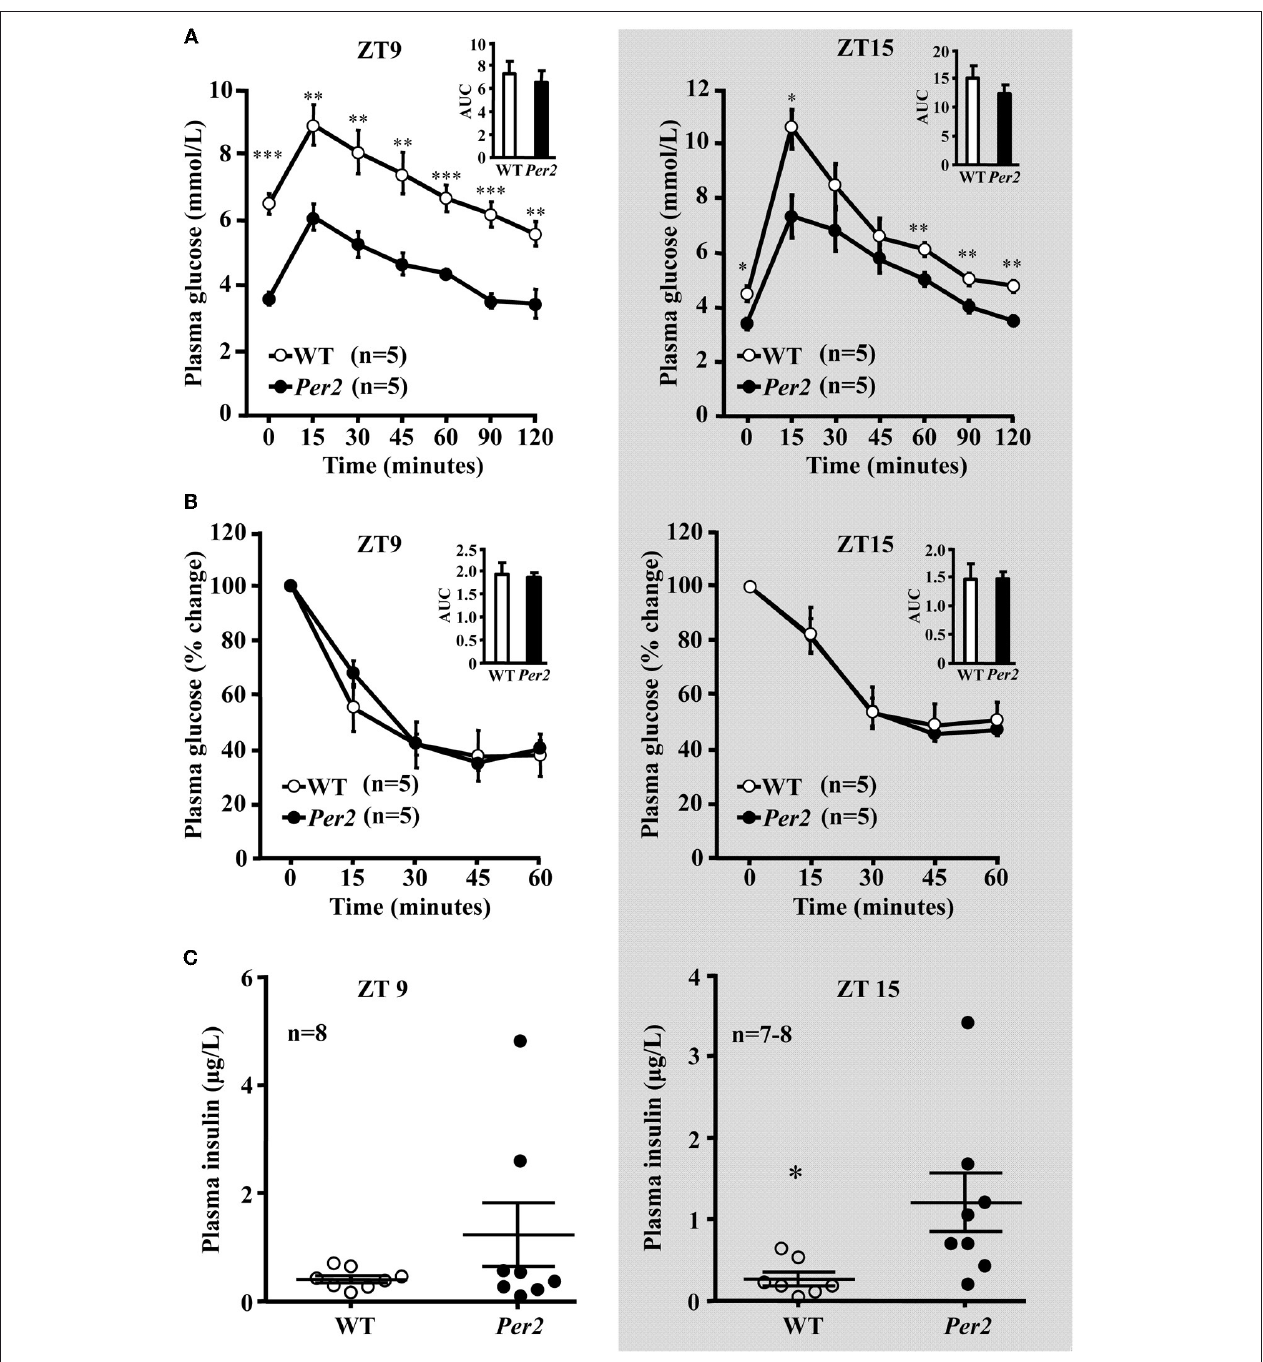
FIGURE 5 | GTT, ITT test, and basal plasma insulin concentration in mPer2 Brdm1 mice. (A) Glucose tolerance test, (B) insulin tolerance test, and (C) basal fasting plasma insulin levels in the mPer2 Brdm1 and WT mice at ZT9 and ZT15 (one blood sample from a WT mouse was lost during preparation); ∗ p < 0 . 05 and ∗∗ p < 0 . 01, and ∗∗∗ p < 0 . 005 vs. mPer2 Brdm1